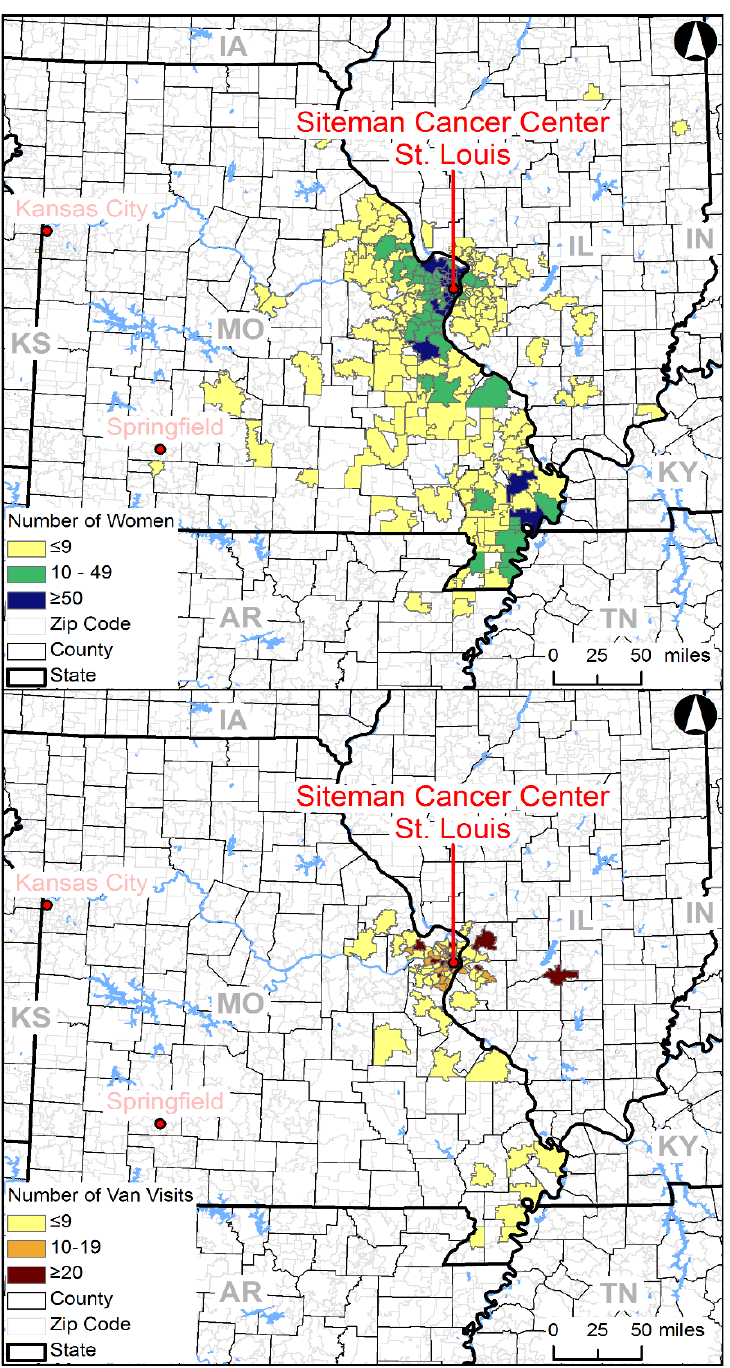
Figure 1. Number of women served (top) and van visits (bottom) by zip code.